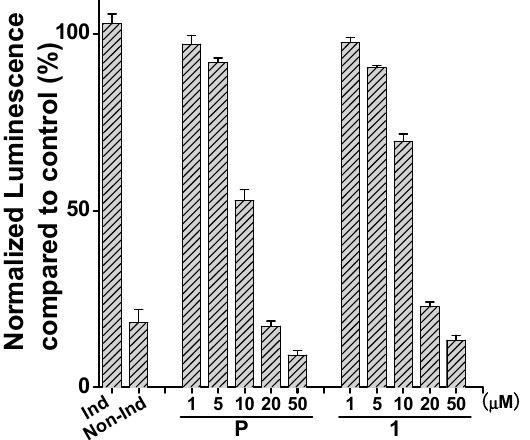
Figure 3. Compound 1 inhibited TNF- α -induced NF- κ B activation by NF- κ B-luciferase inhibition assay in RAW264.7 cells. 1 and parthenolide ( P , positive control) were dosed to RAW264.7 cells containing a stably transfected NF- κ B luciferase reporter and stimulated with TNF- α (50 ng/mL) for 8 h (except for a non-induced control, Non-Ind). Luminescence was normalized to the non-compound induced (Ind) control and plotted as NF- κ B luciferase activity (%). Mean ± standard deviation values are shown with more than three replicates.